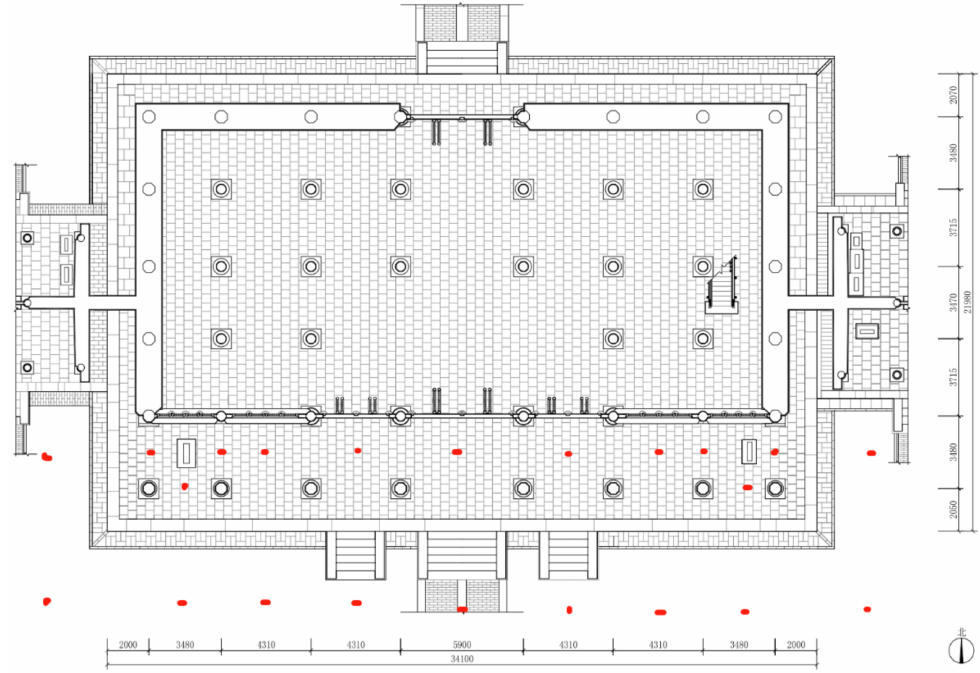
Figure 4. Sites (red spots) in the corridor, by the stone tablet, and under the outer eaves. During ground acquisition, a countdown of 3 s to 8 s was set so that the photog- rapher could move to the appropriate position to avoid occupying too many areas for image acquisition. If possible, GPS functions were activated to auto-link hotspots in the virtual